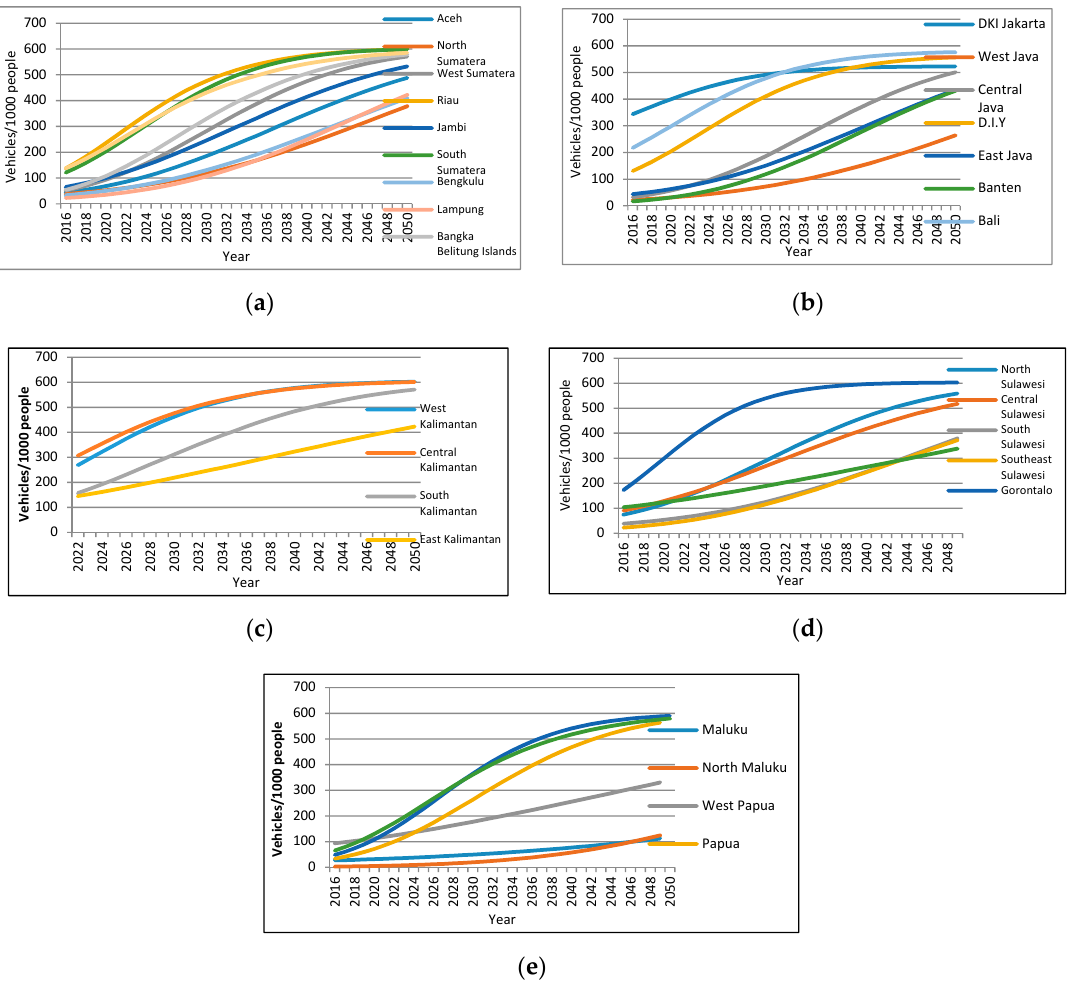
Figure 10. Projection of car ownership in ( a ) Sumatra ( b ) Java ( c ) Kalimantan ( d ) Sulawesi ( e ) Nusa Tenggara, Maluku, Papua.